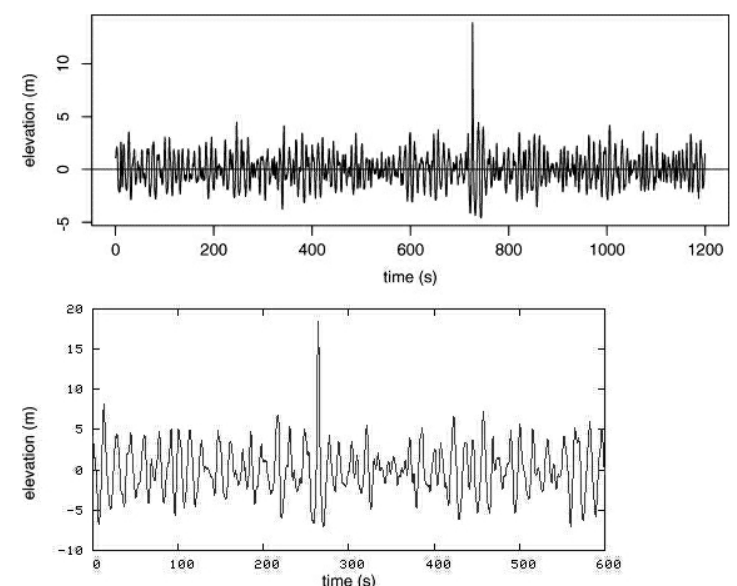
Figure 1. The laser readings of the most extreme rogue wave registered ( top ), which hit the the North Alwyn platform east of Shetland [5], reaching 18.04 m and a ratio of 3.19 × the surrounding waves. Figure 1 . The laser-readings of the most extreme rogue wave registered (top), which hit the 34 ( Bottom ) The New Years wave registered in 1995 on the Draupner platform in the North the North Alwyn platform east of Shetland [5], reaching 18.04 meters and a ratio of 3.19X with 35 surrounding waves. Bottom: The New Years wave registered in 1995 on the Draupner platform (top) 36 in the North Sea. 37